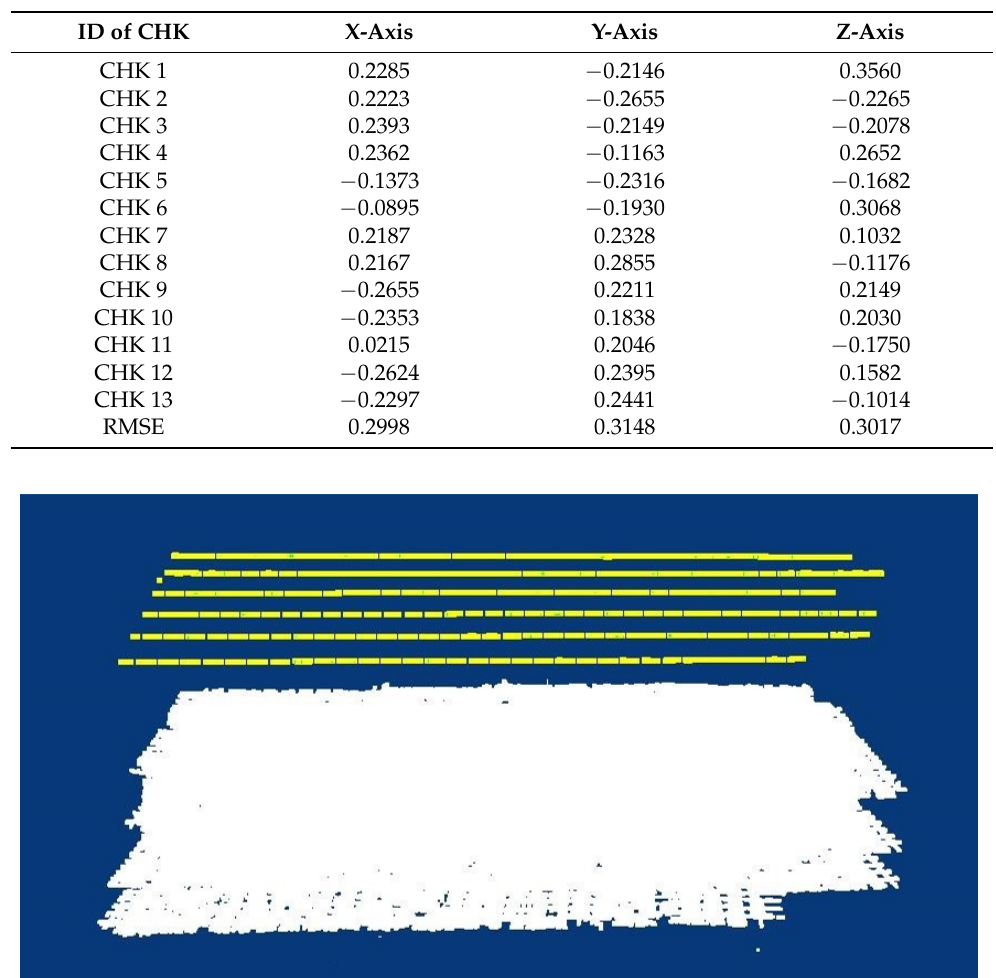
Table 6. Statistical Values for CHKS after the Fourth Experiment (Unit: meter).